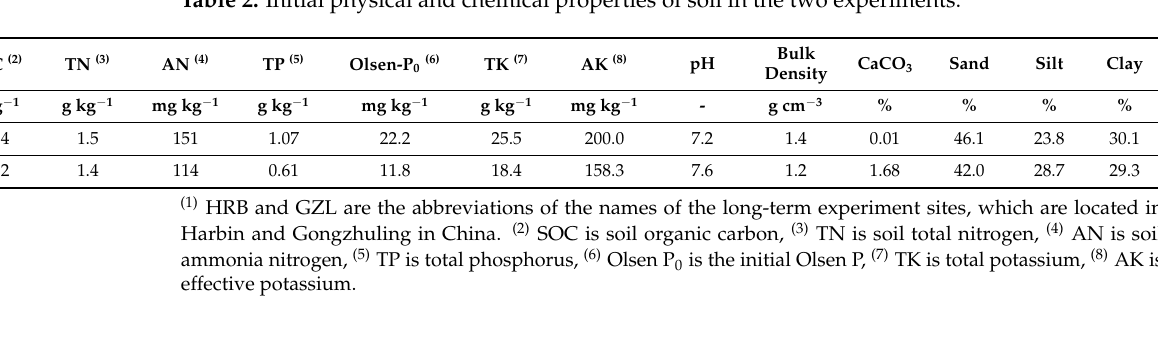
Table 2. Initial physical and chemical properties of soil in the two experiments.